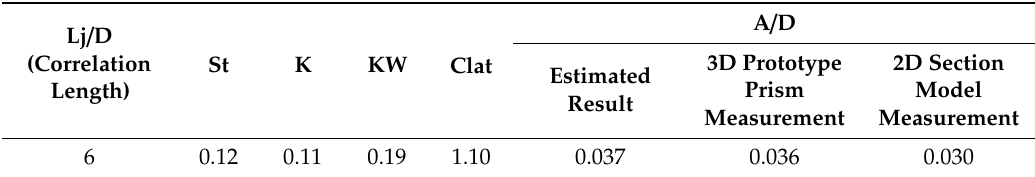
Table 2. Comparison of vortex-induced vibrations (VIV) amplitude between predicted and Comparison of vortex-induced vibrations (VIV) amplitude between predicted and experimental results. experimental